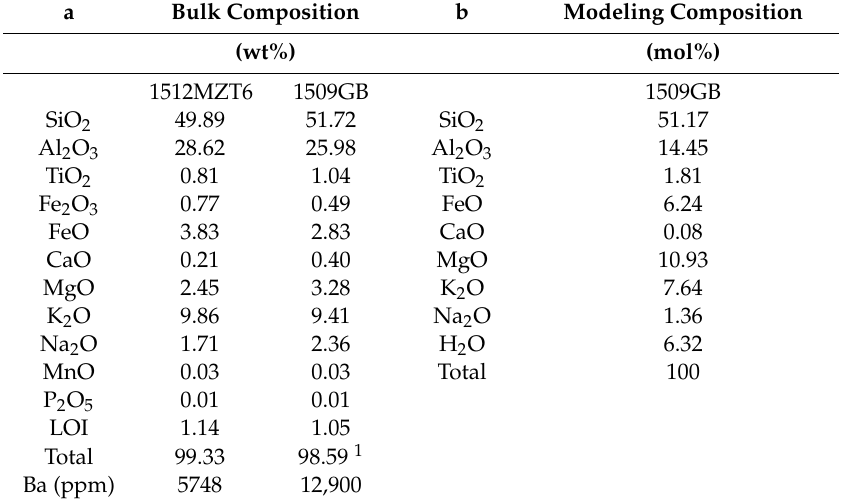
Table 1. Whole-rock chemical compositions of corundum-bearing rocks in wt% ( a ) and E ff ective bulk compositions of 1509GB used for phase diagram modelling in mol% ( b ). a Bulk Composition b Modeling